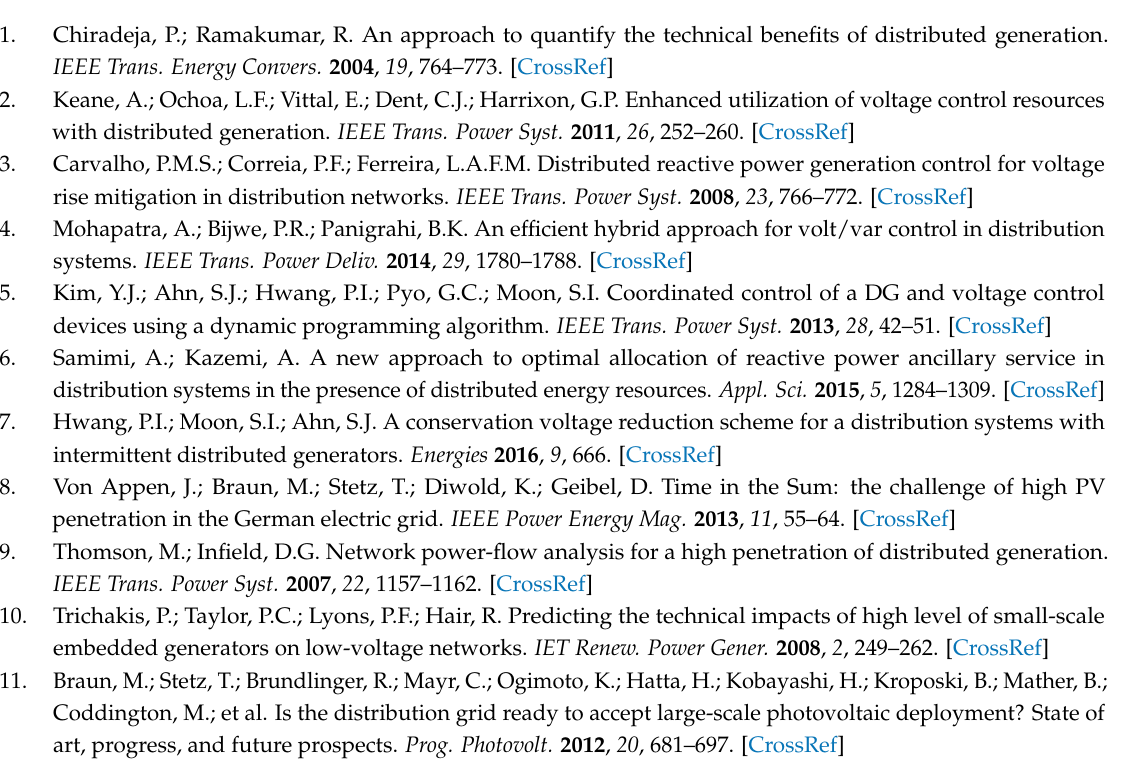
Figure A2. Error in the network power loss and residual power injection for low-voltage system 3. ( a ) Network power loss; and ( b ) residual power injection.